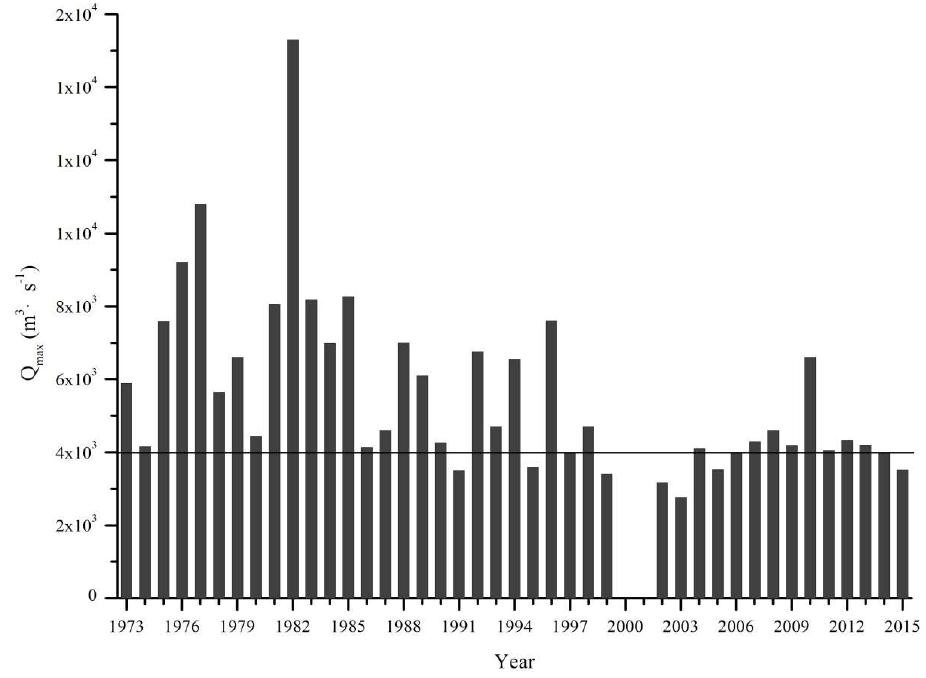
Figure 7. Variation of the annual maximum flow discharge recorded at the Huayuankou gauging station between 1973 and 2015 (the maximum flow discharges occurred in 2000 and 2001 are unavailable because there was no hydrological data of this period